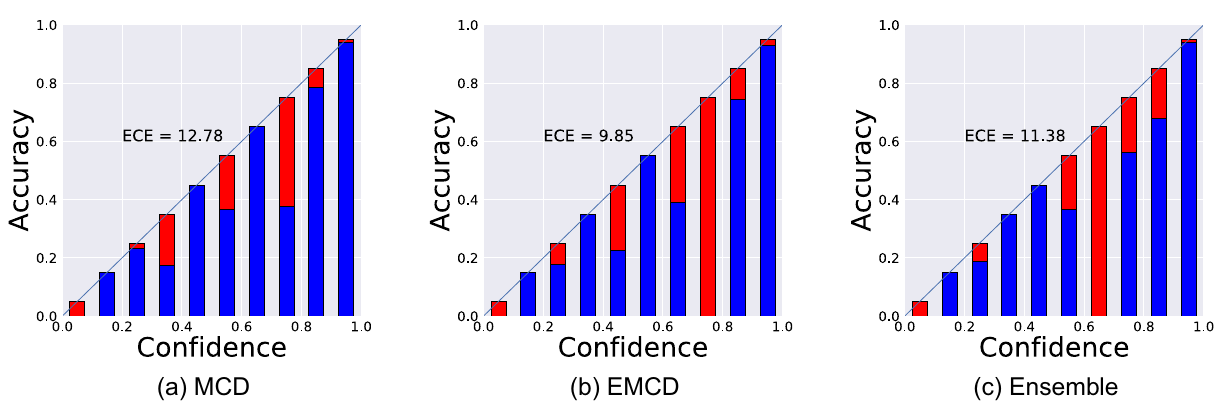
Figure 3. The reliability diagrams (ECE plots) of the trained DNNs. MCD, EMCD, and Ensemble models all have a high ECE indicating miscalibration of generated